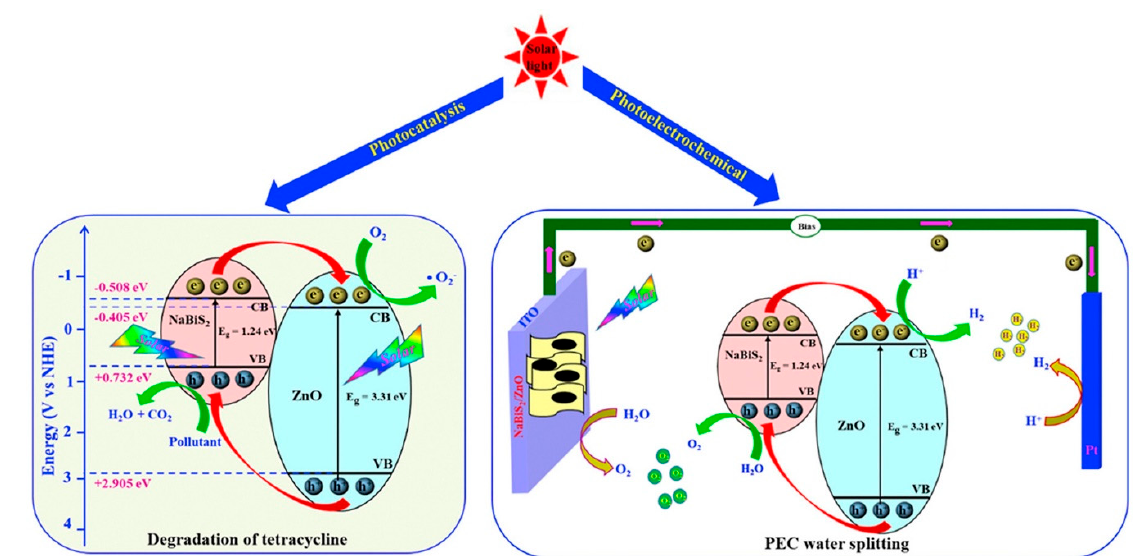
Figure 10. A comparative analysis of photocatalytic activity of doped nZnO for the photodegradation of organic pollutant (tetracycline) and for photocatalytic water splitting. Reprinted with permission from Reference [68]. Copyright 2021, with permission from Elsevier.